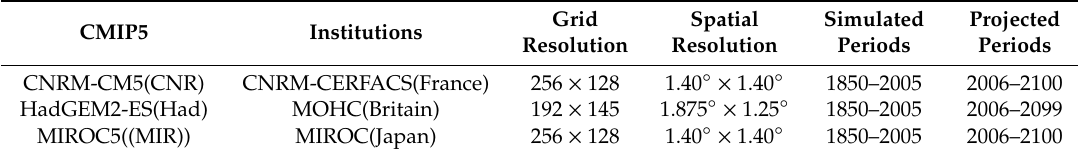
Table 1. Basic information of the three CMIP5 models.